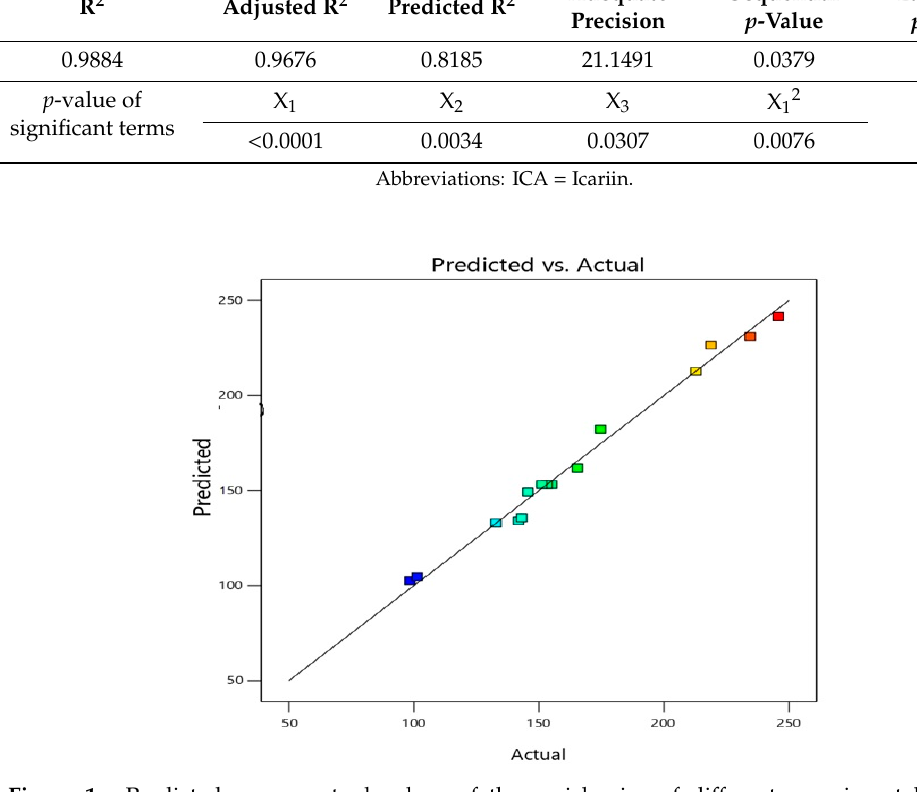
Table 3. Statistical analysis output of the measured vesicle size of ICA-phytosomes.